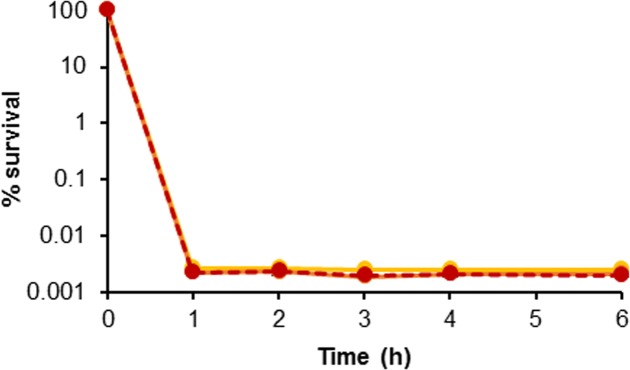
Evaluation of persister cell heritability. Kill curves of H. volcanii following repeated challenges of surviving colonies in 0.005% H2O2. Yellow, orange, and red lines are replicate 1, 2, and 3, respectively. Plotted values are the mean of triplicate measurements and error bars represent ± SD.